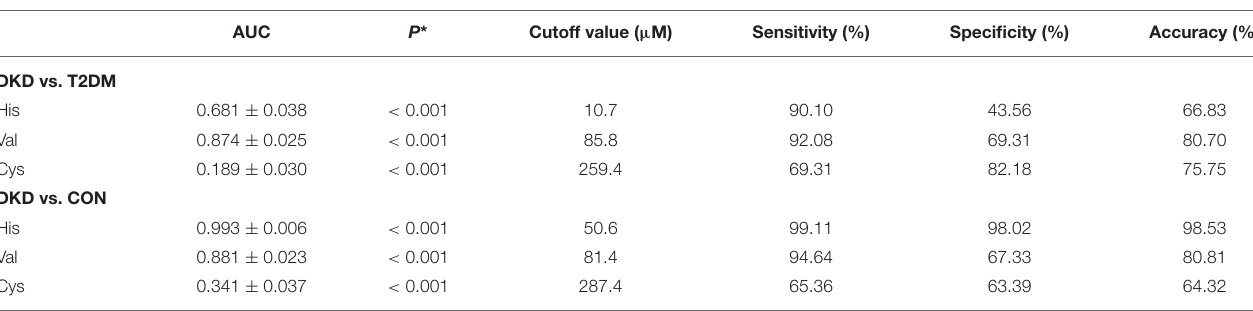
TABLE 2 | Predictive performance of the key amino acids. AUC P * Cutoff value ( µ M) Sensitivity (%) Specificity (%) Accuracy (%) DKD vs.